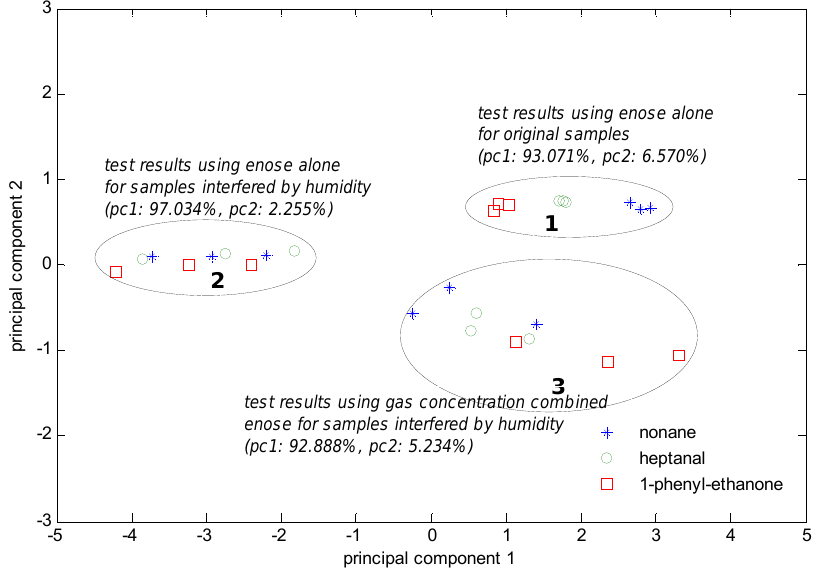
Figure 6. PCA of the three odorant gas samples strongly interfered by